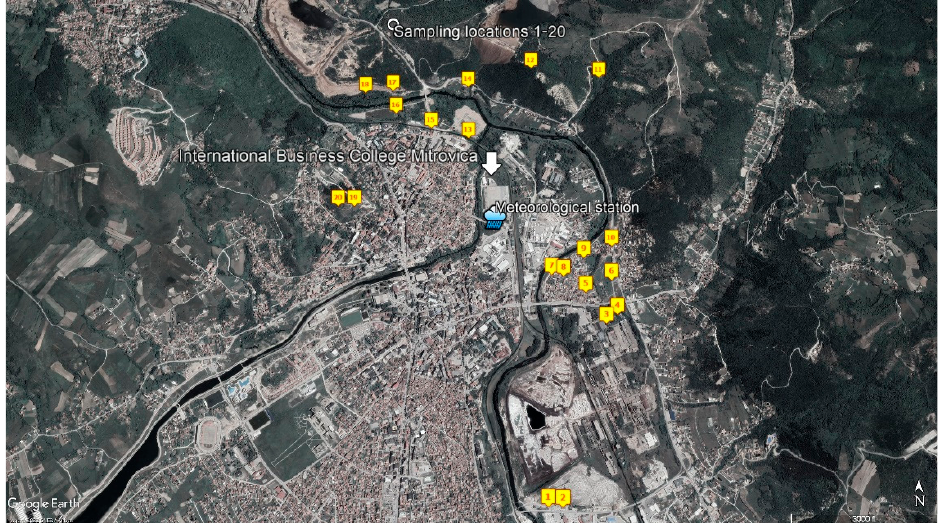
Figure 1. Jarosite waste deposit surrounding terrain with sampling locations (yellow), meteorological station (blue mark), and the location of the probe measuring PM 10 and PM 2.5 at the International Business College building